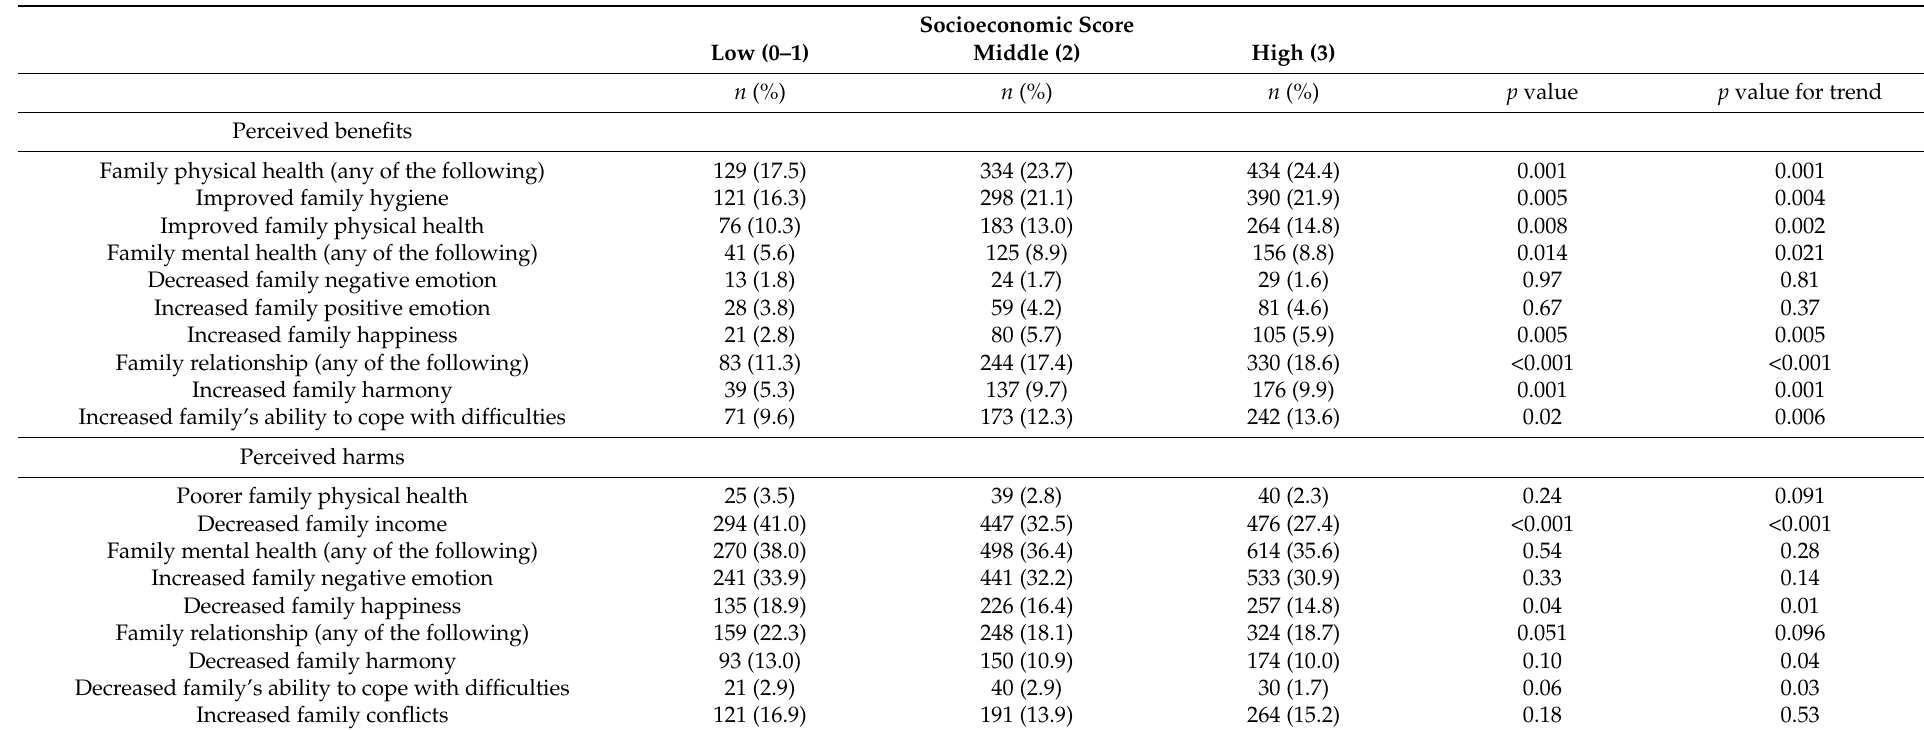
Table 3. Perceived benefits and harms of COVID-19 by socioeconomic